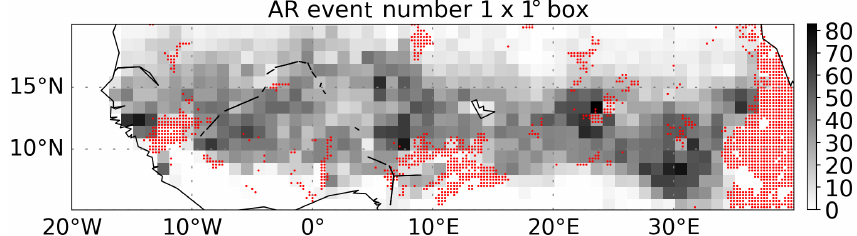
Figure A3. Number of identified afternoon rain events aggregated over 1 × 1 ◦ grid boxes (gray shading) and applied orography mask at the 0.25 ◦ horizontal resolution (red